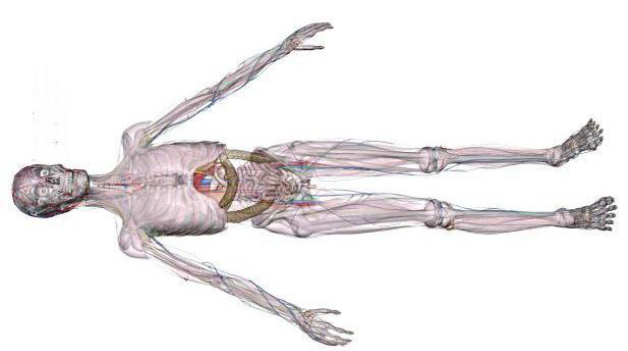
Fig. 4. 3D model of the human body (without the